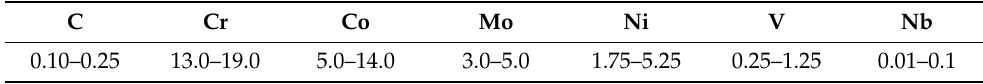
Table 1. Chemical composition of CSS-42L alloy (wt.%).